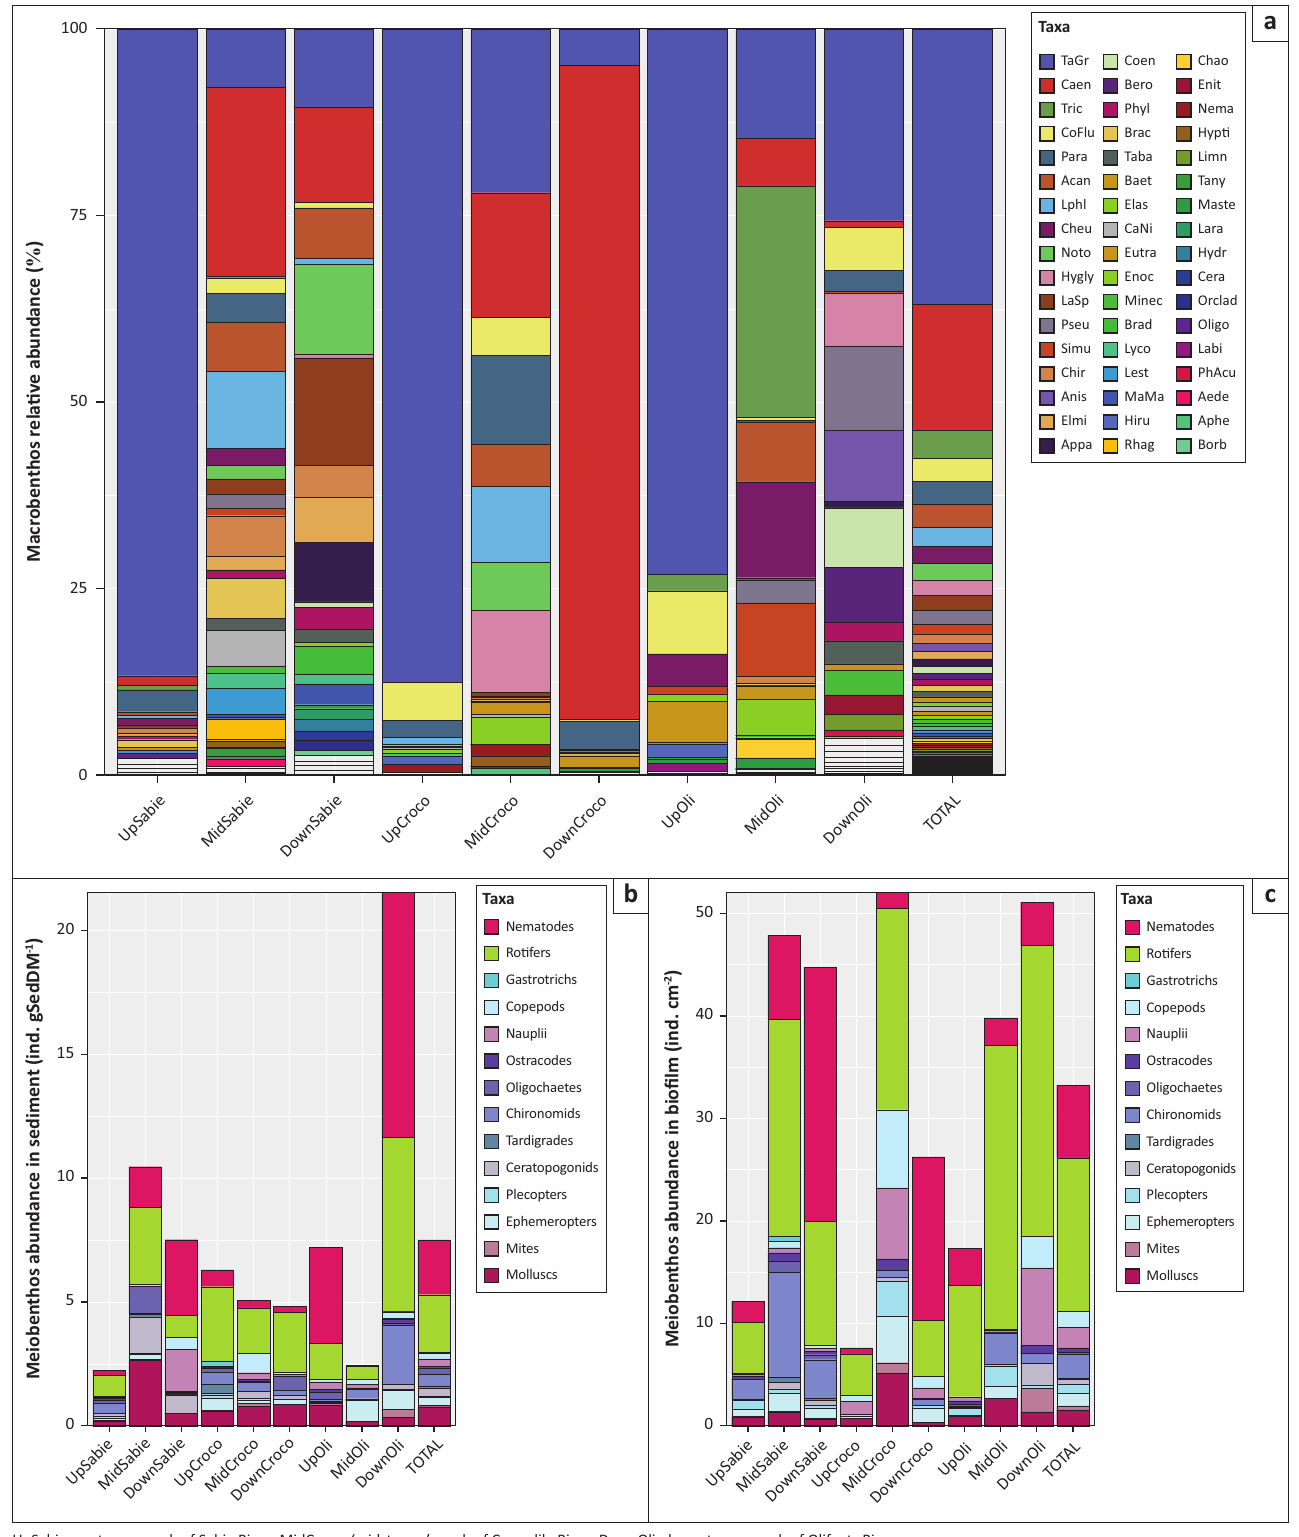
FIGURE 2: Composition of the benthic invertebrate community in three rivers flowing through the Kruger National Park, South Africa. (a) Mean ( N = 5) relative composition of the macrobenthic community at each sampling site. Only the first 51 most abundant taxa out of 82 have assigned coloured legend. Taxa abbreviations are detailed in Table 1-A1. (b) Mean ( N = 5) abundance and composition of the meiobenthic community in the sediment. (c) Mean ( N = 5) abundance and composition of the meiobenthic community in biofilms. Examples of sampling